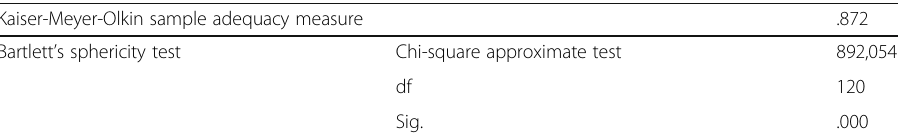
Table 2 KMO measure and Bartlett ’ s sphericity test Kaiser-Meyer-Olkin sample adequacy measure